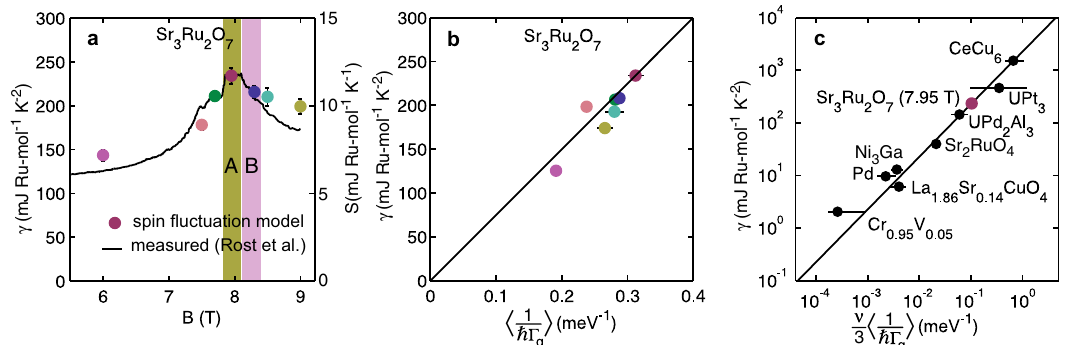
Fig. 3 Spin fl uctuations and the speci fi c heat capacity. a Circles show the low-temperature linear co-ef fi cient of the heat capacity γ calculated using the phenomenological spin- fl uctuation model described in the text and our experimentally determined parameters. Solid line is the measured γ of Rost et al. 10 . Note the spin- fl uctuation model predicts increases of γ approaching B c and on entering SDW phases A and B. b The measured γ 10 for fi eld values in panel a ( fi elds denoted by colours) plotted against the Brillioun-zone-averaged inverse spin relaxation rate 〈 Γ ( Q ) − 1 〉 . c The measured γ plotted against the experimentally determined 〈 Γ ( Q ) − 1 〉 for a variety of correlated electron metals 27,28 . Solid line is Eq. (3) and ν = 3 for all systems except Sr 3 Ru 2 O 7 where ν =